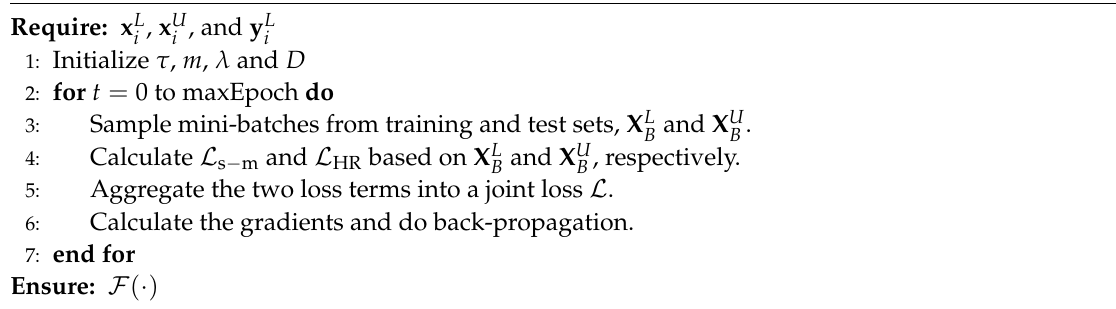
Algorithm 1 Optimization for HR-S 2